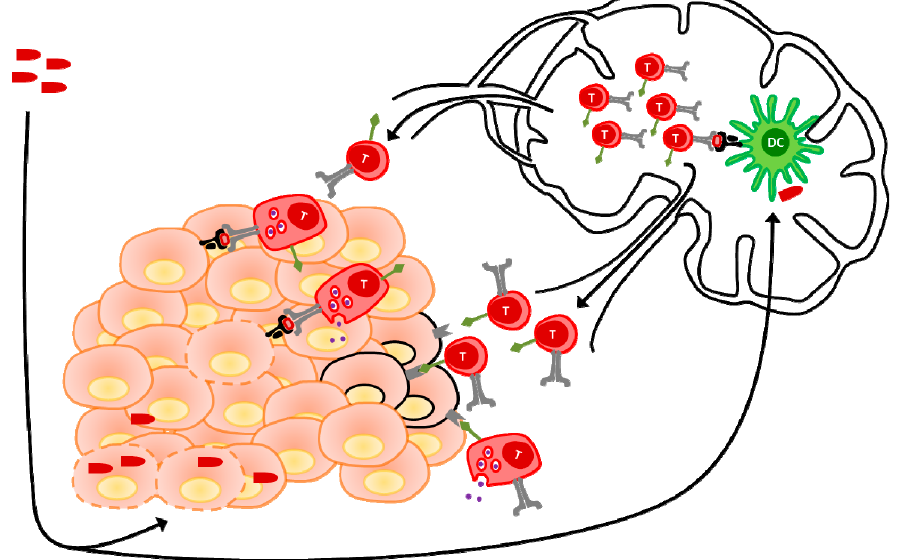
Figure 4. Combination of dual-specific ACT and OVV therapy. T cells with native TCR specificity for a TAA are engineered to express a recombinant TCR or CAR in order to generate dual specific T cells for ACT. Serial injection of dual specific T cells and an OVV serves to activate T cells through TCR stimulation and recruit them to the tumor where they can detect TAA positive cells and attack the tumor through either TCR or CAR binding of its target. In this way, tumors with heterogeneous TAA expression can be effectively targeted and destroyed with one combination therapy.